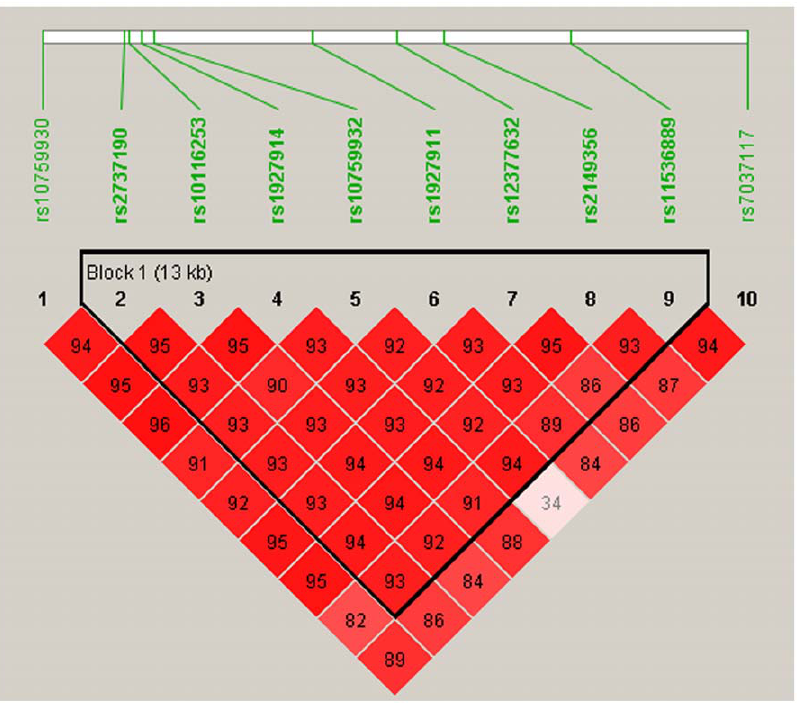
Figure 1. Linkage disequilibrium plot of ten SNPs of the TLR4 gene in patients with hepatocellular carcinoma. D’ corresponding to each SNP pair are expressed as a percentage and shown within the respective square. Higher D’ is indicated by a brighter red.